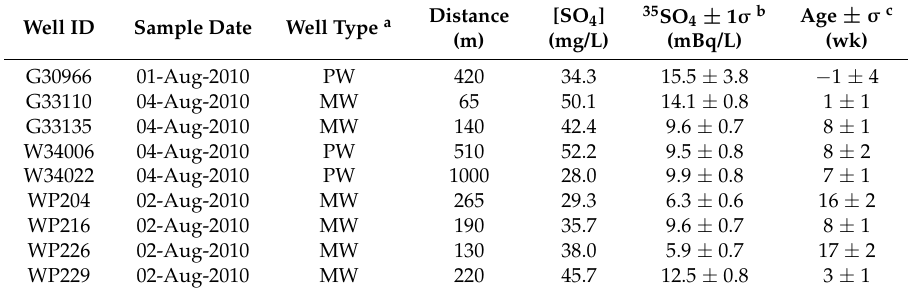
activity of Pond 7 and 12 and the error is the 1 σ propagated counting